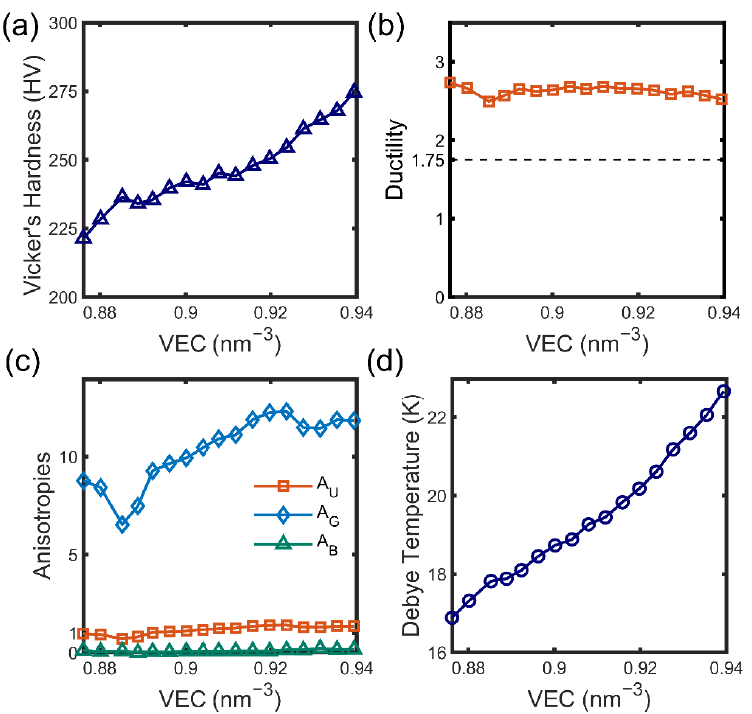
Figure 5. Mechanical and vibrational properties estimated by elastic constants. ( a ) Vicker’s hardness of an empirical model, ( b ) ductility (orange line) predicted from the Pugh ratio ( c ) anisotropies of universal, bulk modulus, and shear modulus, and ( d ) Debye temperature derived from the average sound velocity are presented.